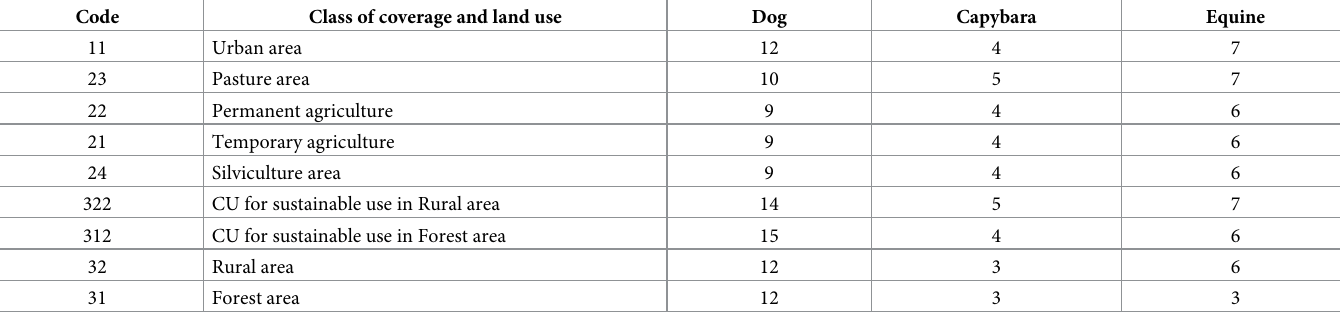
Table 2. Weights relating coverage classes of coverage and land use of Rio de Janeiro state with potential hosts.